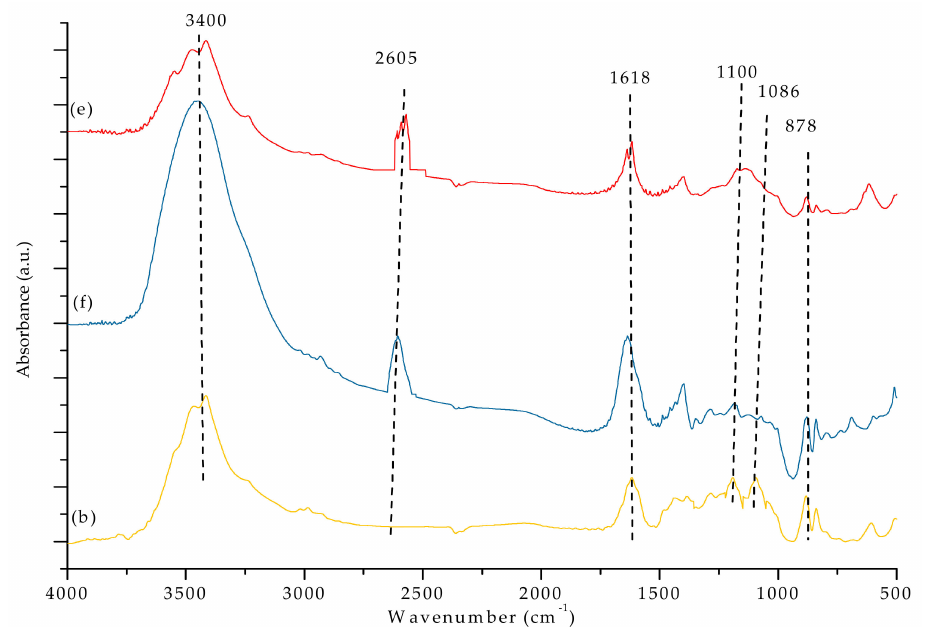
Figure 8. FTIR spectra of the PVDF-SiO 2 -6 membrane ( e ) before and ( f ) after cross-linking, as well as ( b ) after